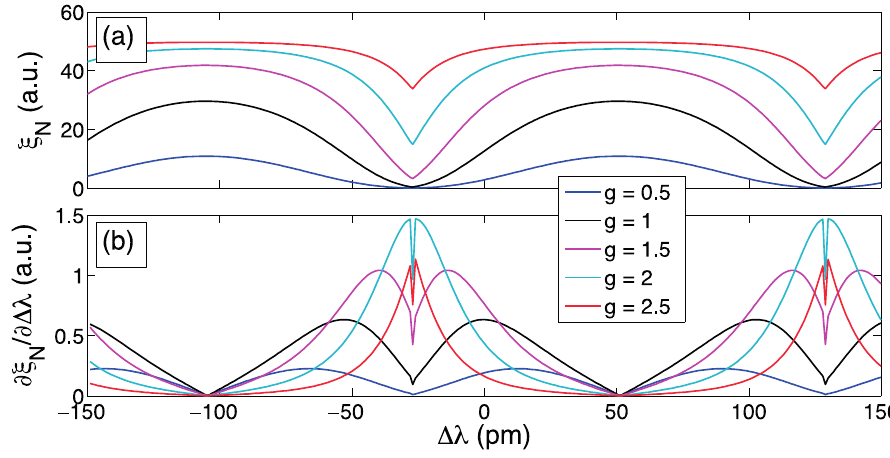
Figure 6. ( a ) ξ N ( Δλ ) function for different values of grating strength coefficient g ; ( b ) derivative of ξ N ( Δλ ).